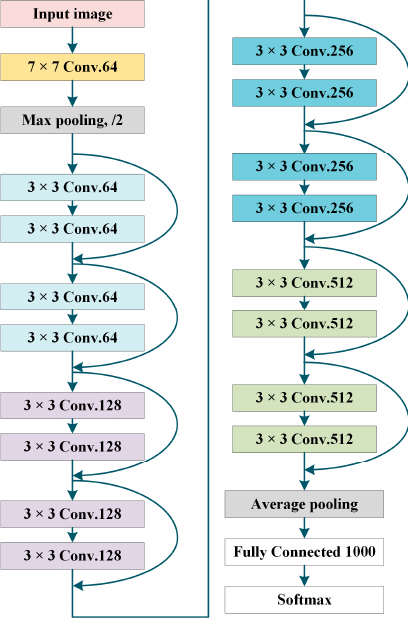
Figure 6. ResNet18 structure diagram.